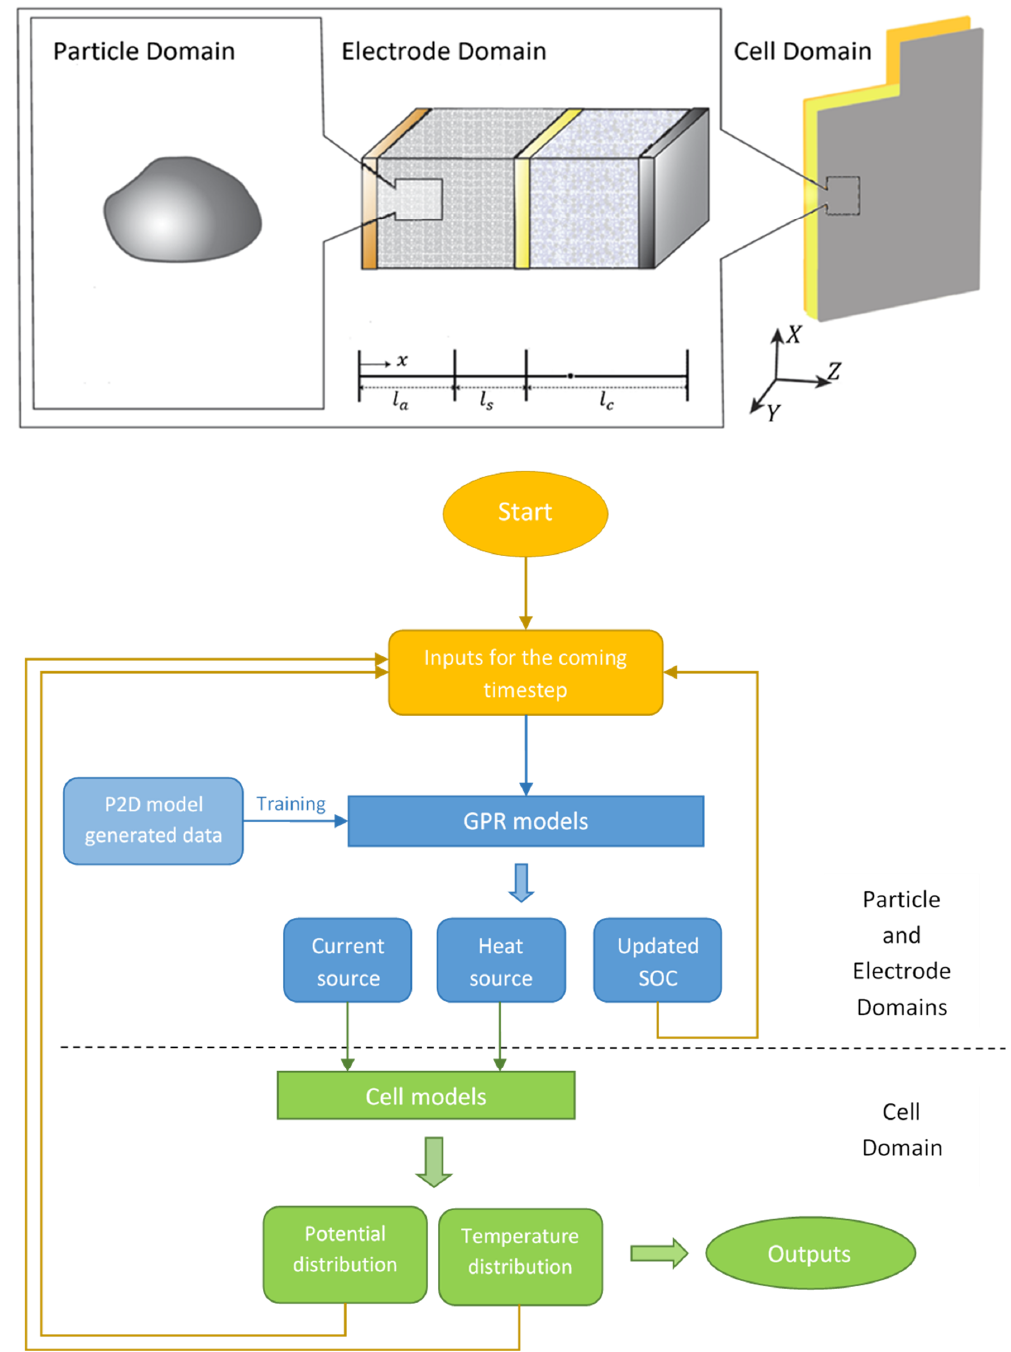
Figure 2. Each new timestep starts with training GPR models. GPR models and the cell models solve for the temperature and electrical potential distributions on the plates in 2D in each timestep, and they become inputs for the next timestep. Gaussian Process Regression is categorized as a nonparametric regression method that gives probabilistic models through extracting the features within the data and pro- vides confidence information [26]. The data space (cid:1798) = [(cid:1824) (cid:2869) , (cid:1824) (cid:2870) ,… , (cid:1824) (cid:3015) ] (cid:2904) represents the (cid:1840) training input data selected from the training input data pool, and (cid:1825) represents the